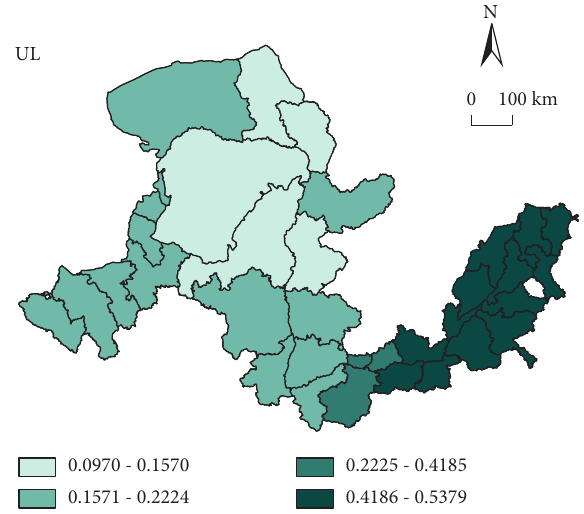
Figure 9: Spatial distribution of regression coefficient of the UL on UGDI.